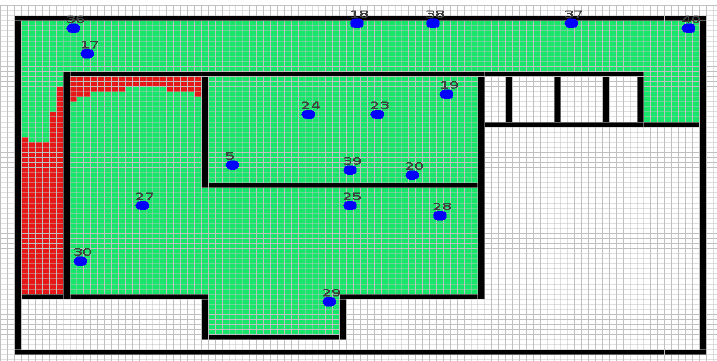
Figure 7. WSN deployment on the second floor of the Strata Conference in New York (NY-2).